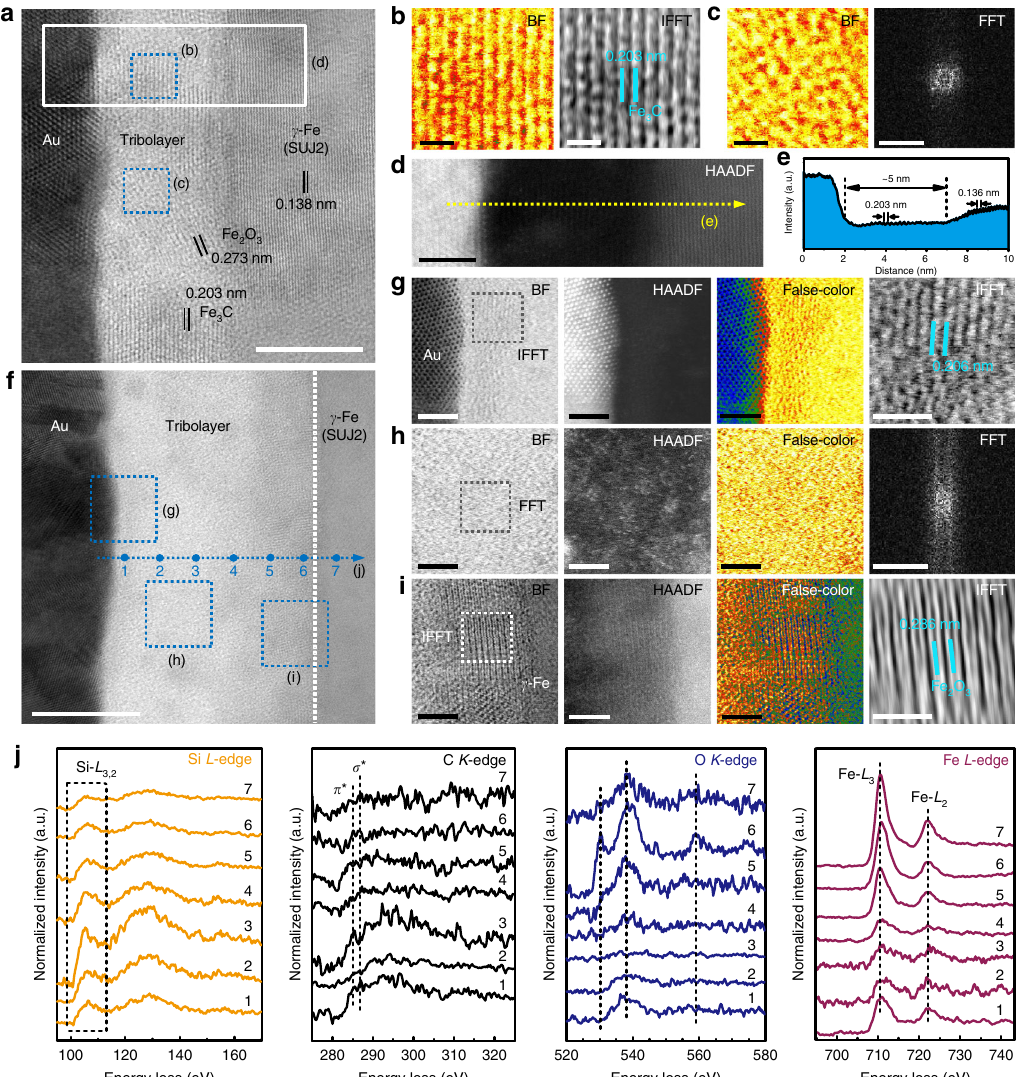
Fig. 5 Characterization of the contact area produced on a-C:H:Si fi lm-coated SUJ2 steel ball surface. The corresponding superlubricity test for self-mated a- C:H:Si (9.3 at% Si, ACF-6) surfaces is shown in Supplementary Fig. 8. The transfer of all the fi lm material from the ball surface to the wafer side and the simultaneous re-generation of tribolayers on both the surfaces demonstrate the reconstruction of the sliding interface (Supplementary Figs 8 and 9). a BF- STEM image showing a mainly C-Fe intermixed tribolayer of ~ 5 nm thickness generated at the ball wear scar center. Scale bar, 5 nm. b , c BF-STEM and IFFT (or FFT) images specifying a highly-crystalized Fe 3 C shear band ( b ) and an amorphous-like local structure ( c ) in the tribolayer as marked in a . Scale bars in b , 0.5 nm. Scale bars of BF and FFT images in c are 0.5 nm and 20 nm − 1 , respectively. d HAADF-STEM image across the tribolayer as marked in a . Scale bar, 2 nm. e Intensity pro fi le along the dashed line as marked in d con fi rming the atomic structure of the tribolayer. f BF-STEM image showing a tribolayer of ~ 20 nm thickness generated on the ball wear scar edge. Scale bar, 10 nm. The tribolayer internally evolved into three individual sublayers (marked as g , h and i ): a well-crystalized Fe-rich sublayer near the sliding interface, a C-rich amorphous sublayer in the middle and a highly oxidized Fe-based sublayer near the steel ball surface. g – i BF-, HAADF-, false-color displayed BF-STEM and local IFFT (or FFT) images of the three sublayers as marked in f . Scale bars of BF-, HAADF-, false-color displayed BF-STEM images in g – i are all 2 nm, while scale bars of IFFT (FFT) images in g – i are 1 nm, 20 nm − 1 and 1 nm, respectively. j Evolution of Si- L , C-K, O- K and Fe- L EELS core-edge spectra recorded across the tribolayer as marked in f concentration near the sliding interface was low (~ 7 at% vs ~ 22 at% for the bulk). The EELS analysis further clari fi ed the bonding evolution in the tribolayer, as shown in Supplementary Fig. 9j, k. The transformation region had a higher fraction of sp 2 - C phase (up to ~ 57%), meanwhile retaining a high density of σ *- hybridized bonds (i.e., C – H, C – Si, C – C). Taking the low hardness into account, the bonding structure of the tribolayer was therefore more like a hydrocarbon polymeric compound. This new phe- nomenon found in tribo-induced carbon hybridization processes, namely Si-triggered tribo-softening of the sliding interface, is a NATURE COMMUNICATIONS | 8: 1675 | DOI: 10.1038/s41467-017-01717-8 |